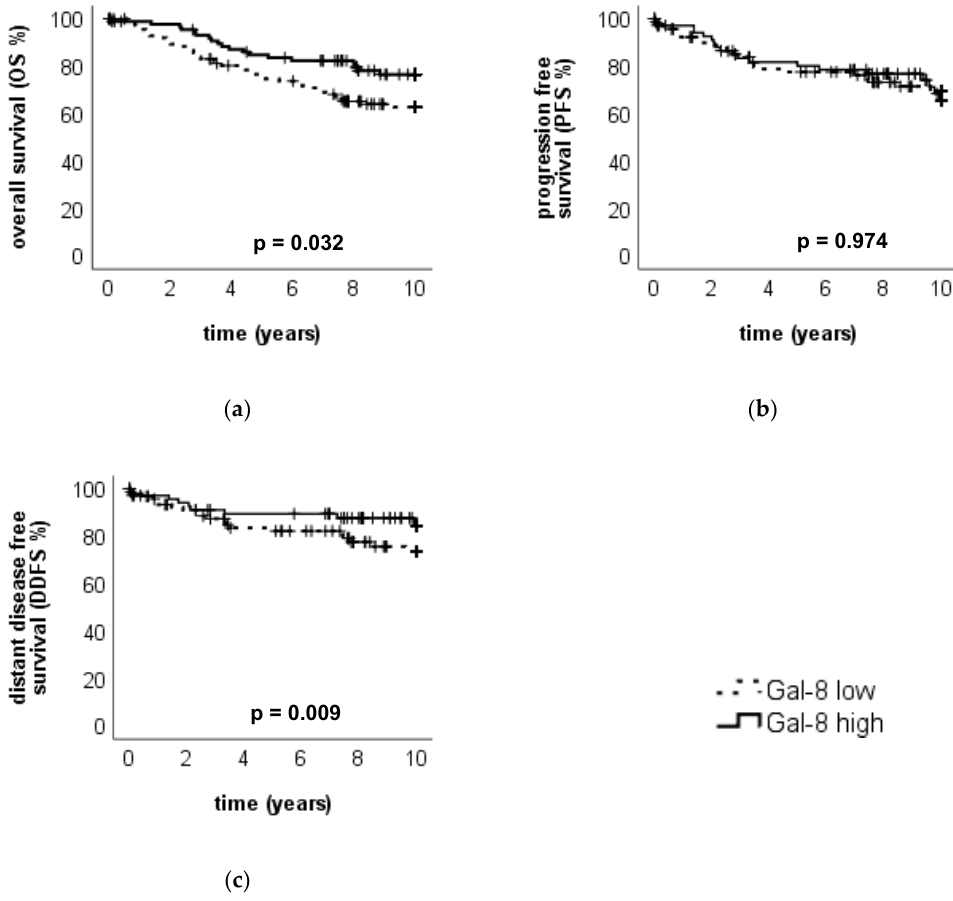
Figure 6. Association of Gal-8 expression in the cytoplasm to the clinical outcome. Kaplan–Meier analysis of OS ( a ), PFS ( b ) and DDFS ( c ) in Gal-8 high- and low-expressing tumors (in the cytoplasm) is shown. Tumors with high Gal-8 expression in the cytoplasm showed a significantly improved OS.